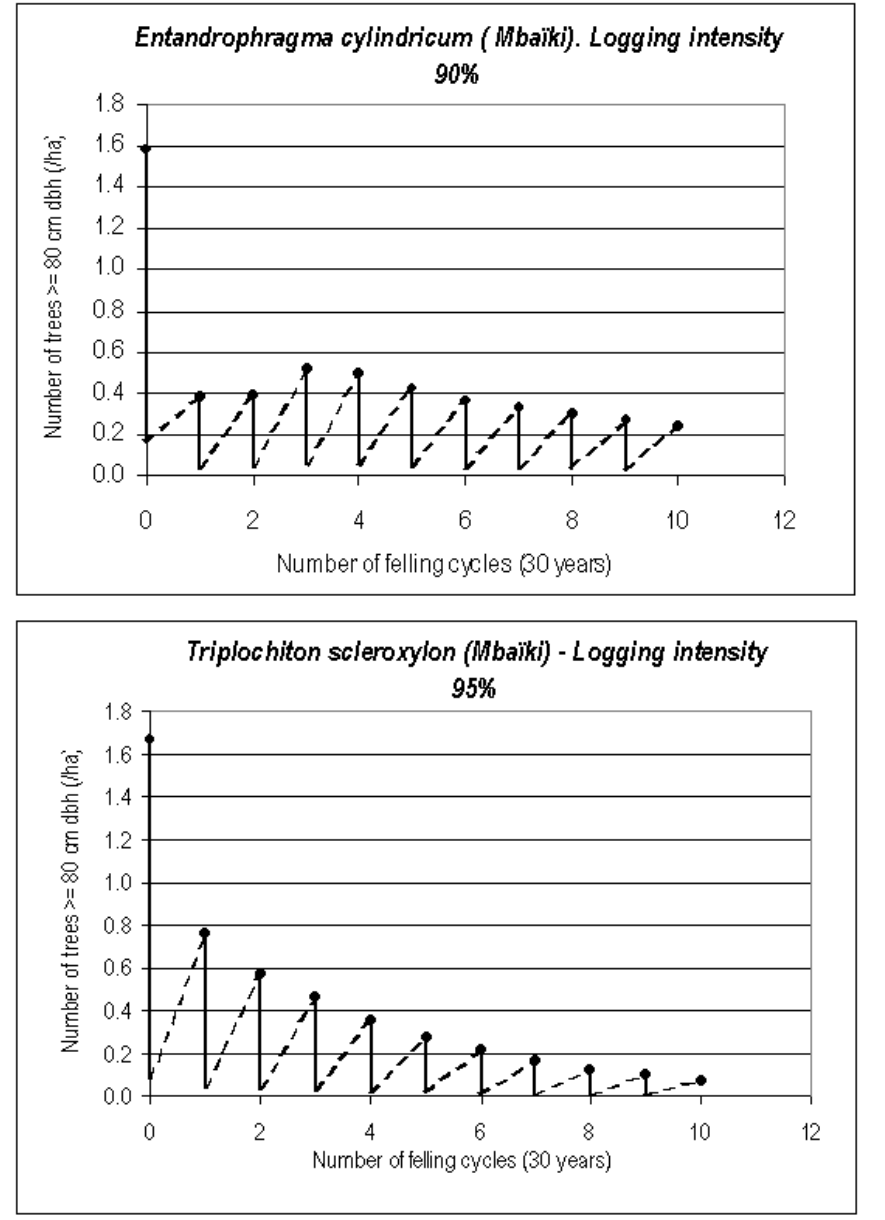
Fig. 2. Evolution of the number of exploitable trees under a repeated felling regime reproducing the parameters of the first logging: diameter cutting limit (DCL) = 80 cm, logging intensity = 90% and 95% of the number of initial standing trees ‡ DCL for Entandrophragma cylindricum and Triplochiton scleroxylon , respectively, felling cycle = 30 yr. Recruitment among the smallest diameter class (10 cm dbh) was linked to the number of trees present in the largest diameter classes ( ‡ 80 cm dbh for E. cylindricum and ‡ 60 cm dbh for T. scleroxylon